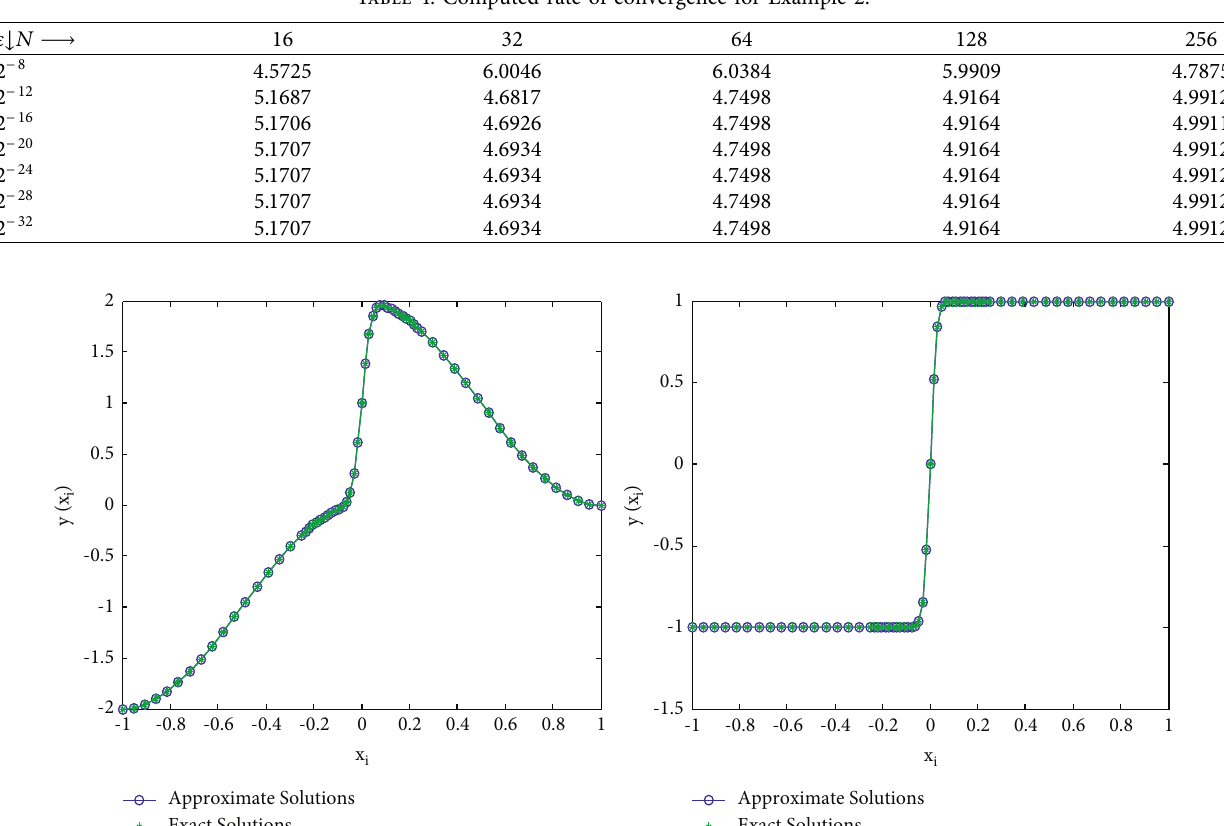
Table 4: Computed rate of convergence for Example 2.